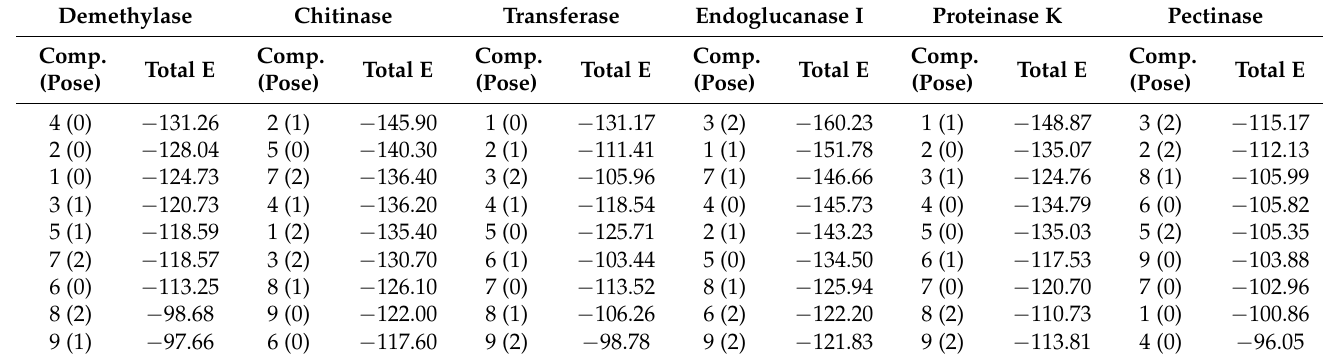
Table 5. Docking score energies (total E/kcal mol − 1 ) of interactions of the best docked poses of nine coumarinyl Schiff bases in complex with: demethylase (sterol 14 α -demethylase (CYP51), PDB ID: 5EAH); chitinase (PDB ID: 4TXE); transferase (N-myristoyltransferase, PDB ID: 2P6G); endoglucanase